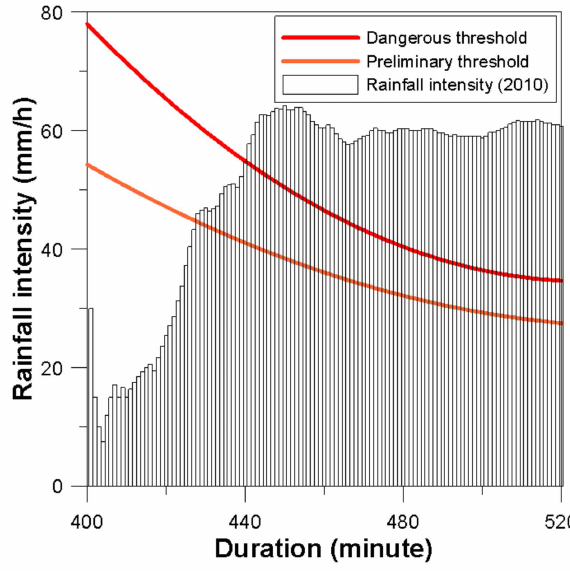
Figure 6. Application of the historical rainfall event in